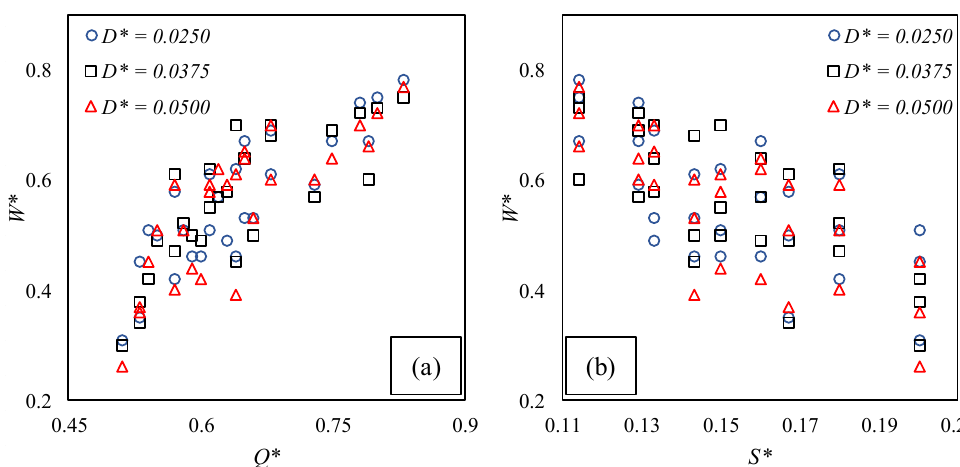
Figure 3. Dimensionless weight of outflowing fibers W* versus dimensionless lateral water outflow Q* ( a ), and dimensionless geometric parameter S* ( b ). Table 1. Mean and standard deviation of the dimensionless weight.